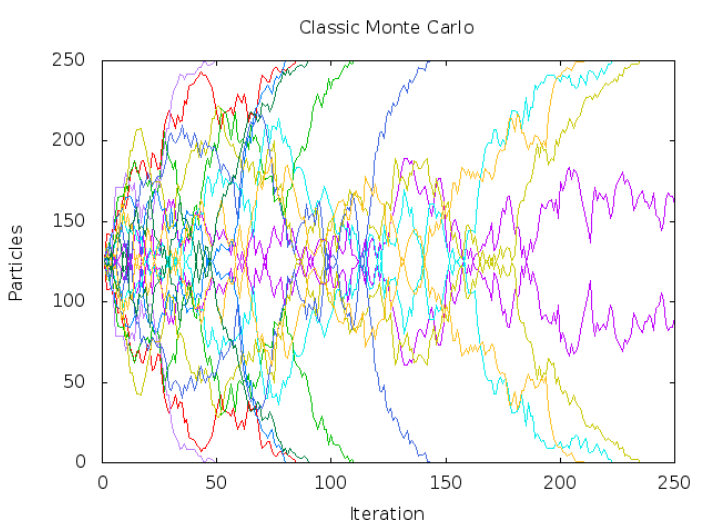
Figure 20. Monte Carlo particles